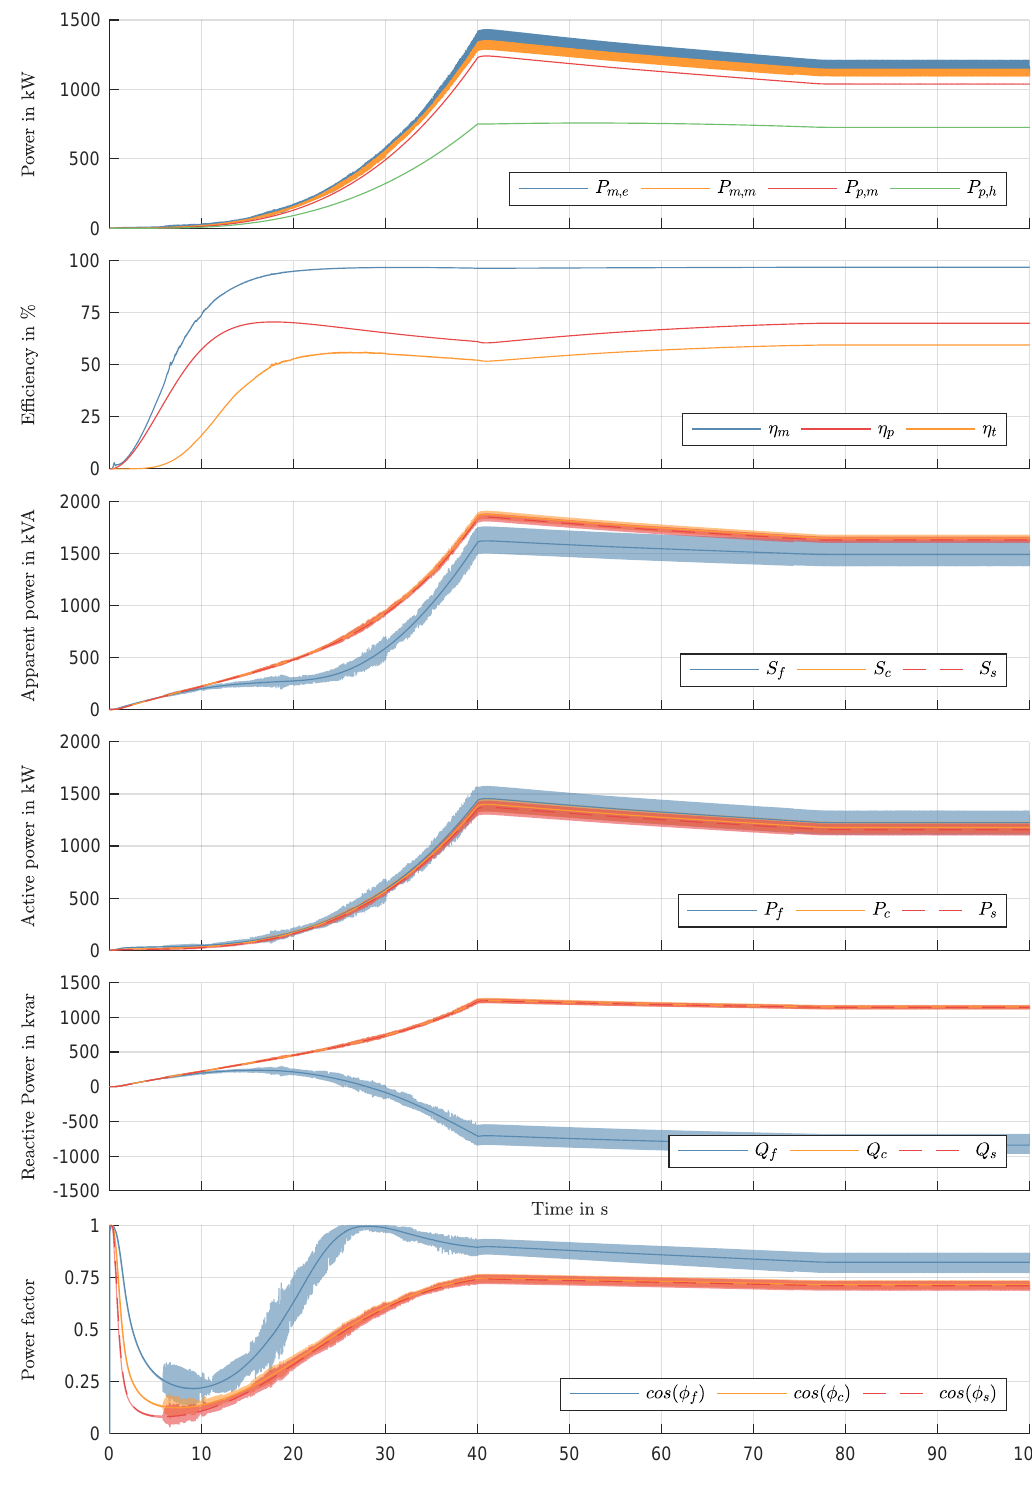
Figure 14. Simulation results (II): Power and efficiency related